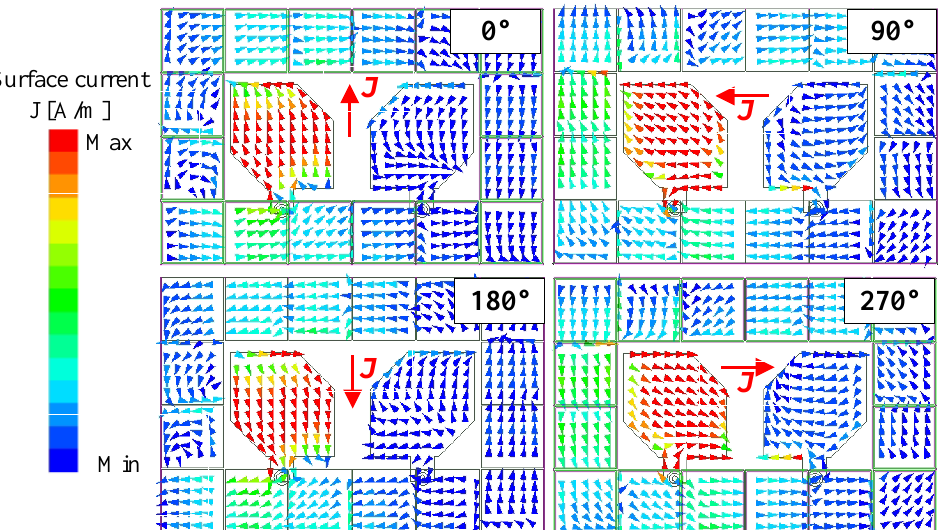
Figure 7. Simulated vector current distributions at 5.2 GHz for the proposed MIMO antenna with Port-1 excitation.